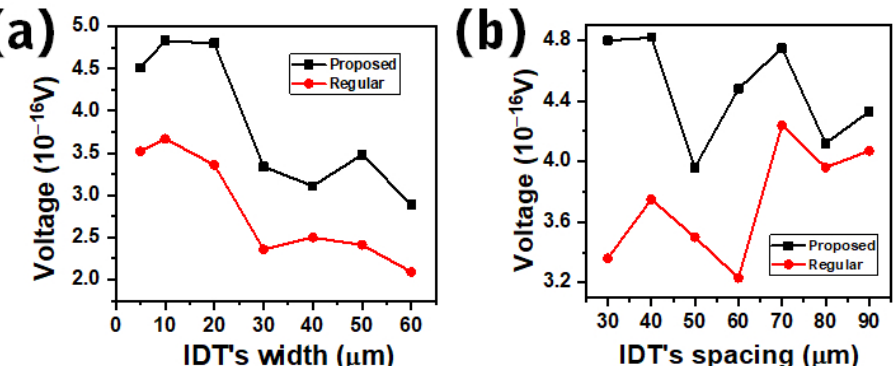
Figure 3. FEM COMSOL simulated results: ( a ) voltage of unit cell of the regular D33 mode, and ( b ) voltage of unit cell of the proposed D33 mode.